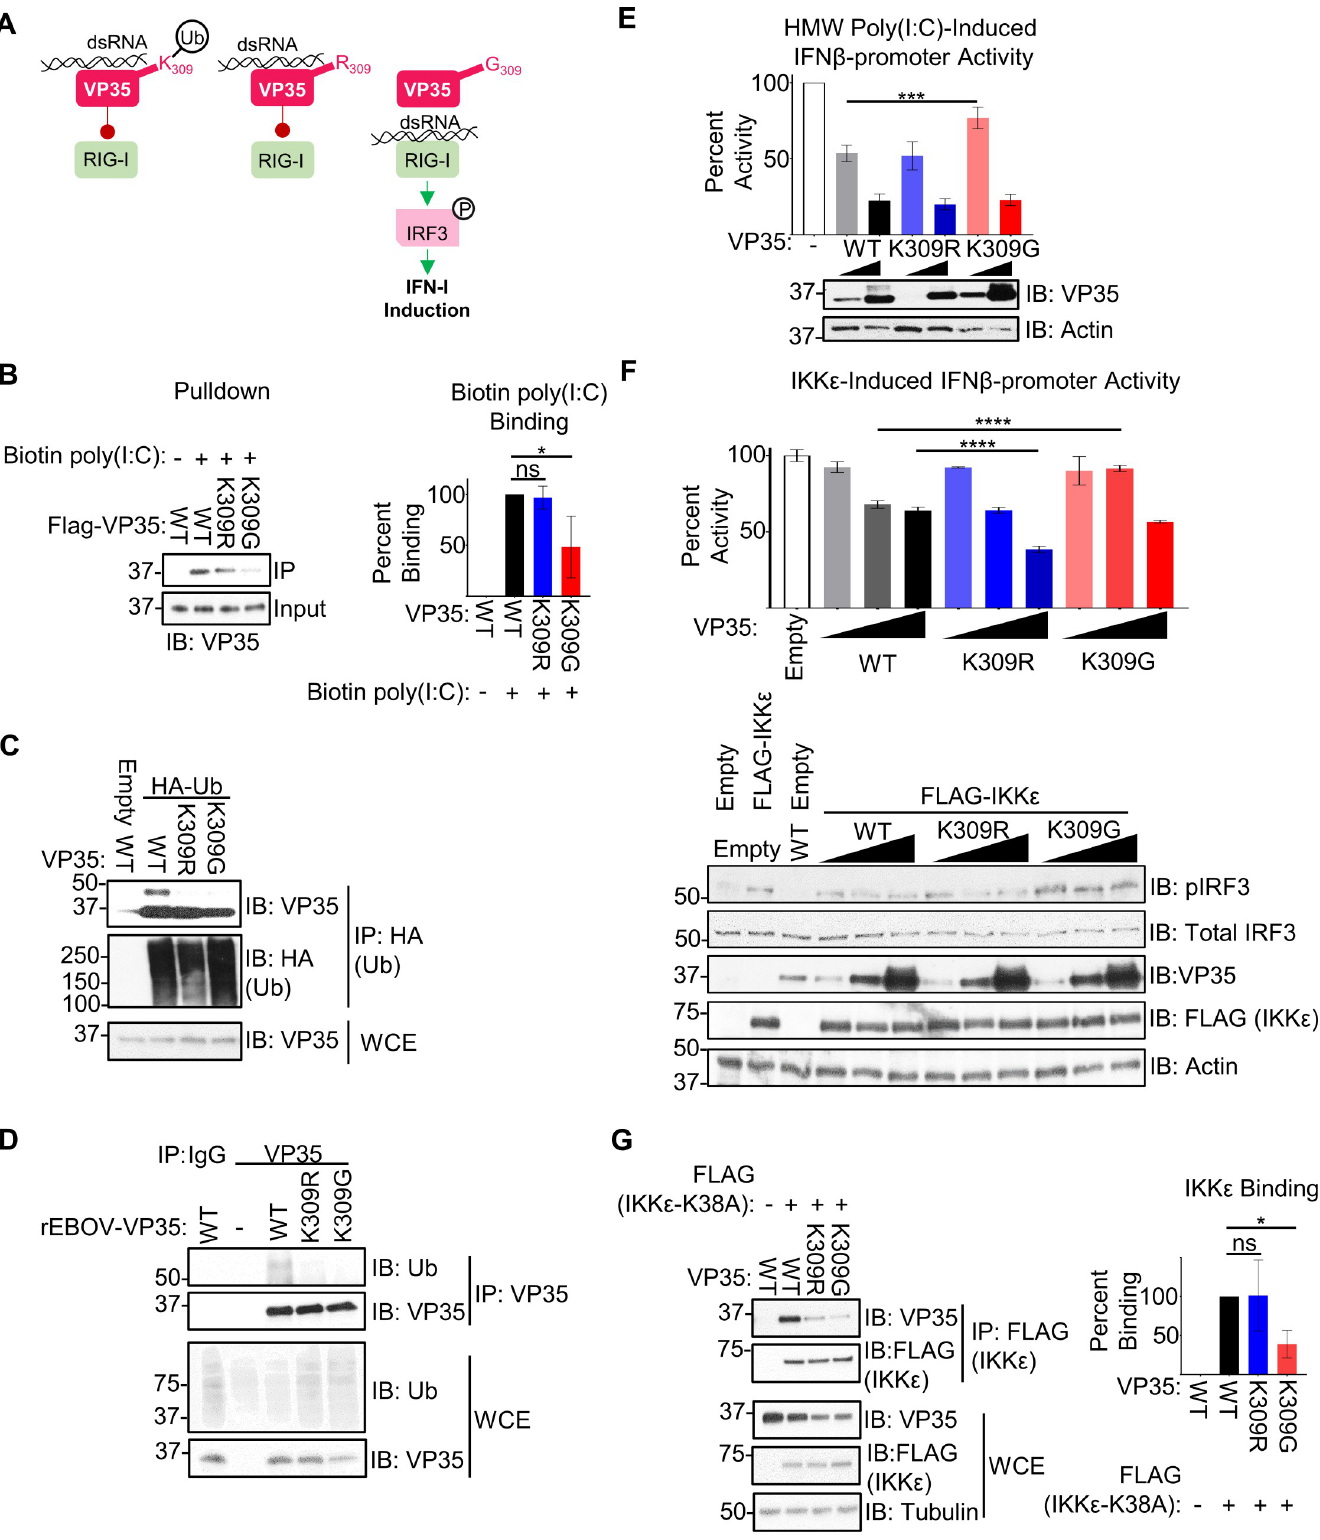
Fig 1. A basic residue and lack of ubiquitination at VP35/309 is required for most efficient IFN-I antagonism. ( A ) VP35 K309 is located in the IFN-inhibitory domain and is involved in binding double-stranded RNA (dsRNA) to prevent the activation of the host’s cytoplasmic RNA sensor RIG-I and is ubiquitinated